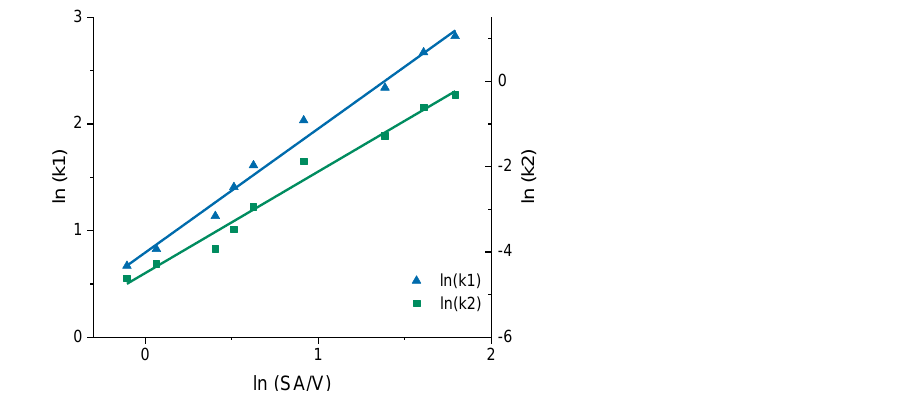
Figure 9. Correlation of the constants k 1 and k 2 of the Peppas Sahlin equation with the SA/V ratio for the EVA-LD formulation.